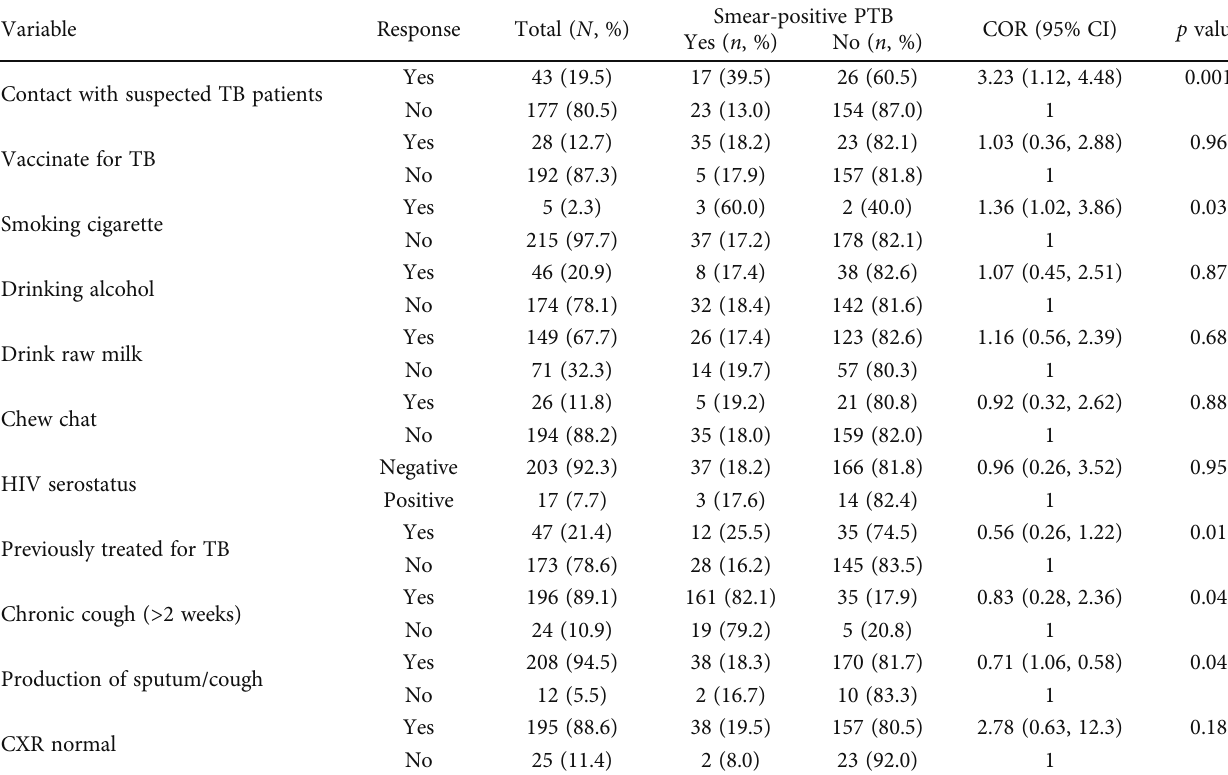
Table 2: Behavioural- and clinical-related characteristics of PTB-suspected patients.